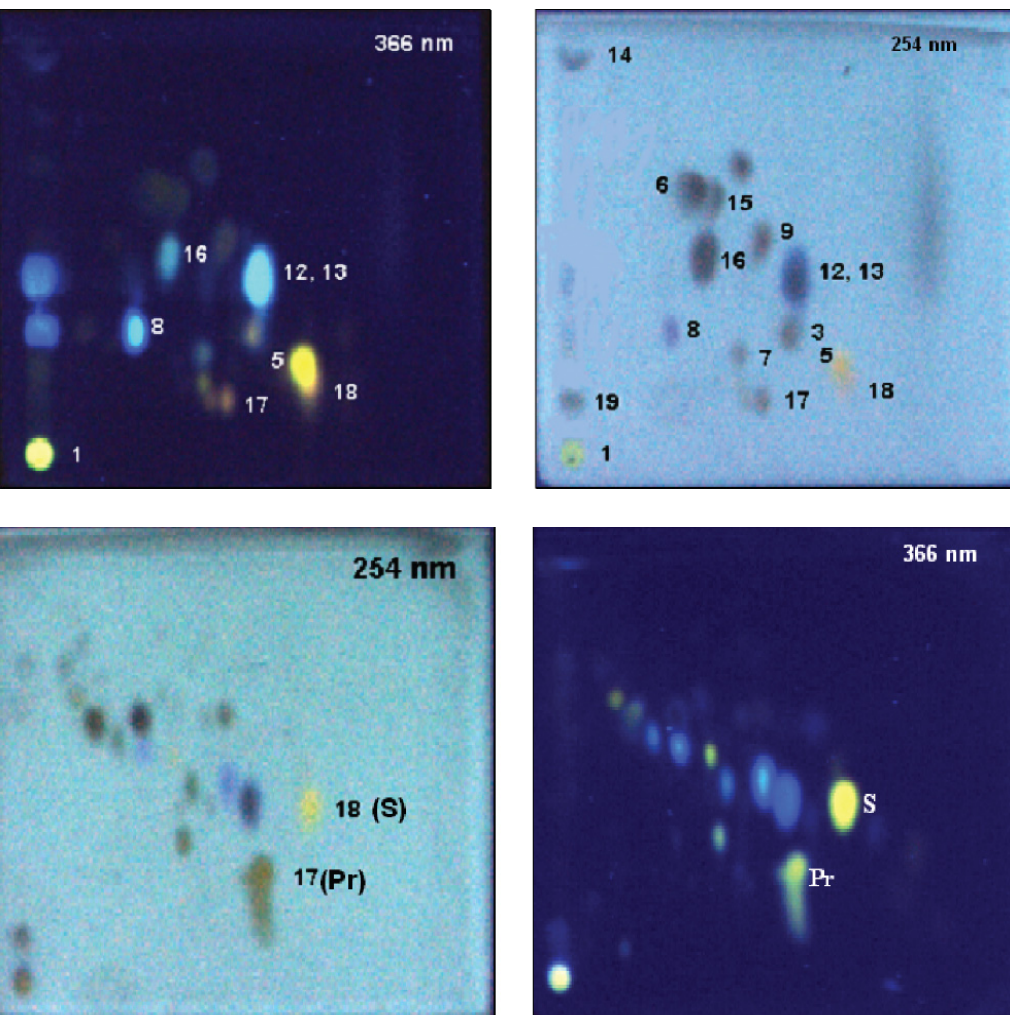
Figure 3. Videoscans of chromatogram (a) for standards of alkaloids scanned at 366 nm and 254 nm. Eluent systems: I direction: 60% MeOH in water + 2% ammonia; II direction: 10% MeOH in diisopropyl ether + 2% ammonia; and (b) of Fumaria officinalis herb extract scanned at 366 and 254 nm. Eluent systems: I direction: 60% MeOH in water + 2% ammonia; II direction: 10% MeOH in diisopropyl ether + 2% ammonia